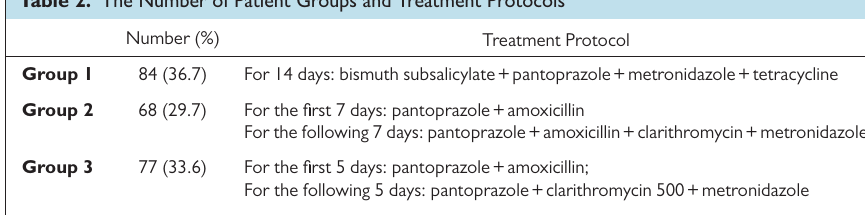
Table 2. The Number of Patient Groups and Treatment Protocols